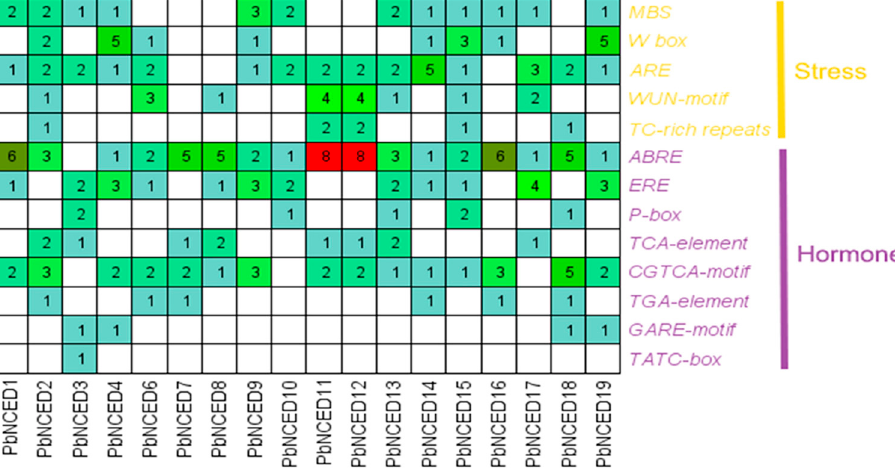
Figure 6. Distribution of stress- and hormone-related cis -elements in the promoter regions of PbNCED genes. The number represents the number of cis -elements.